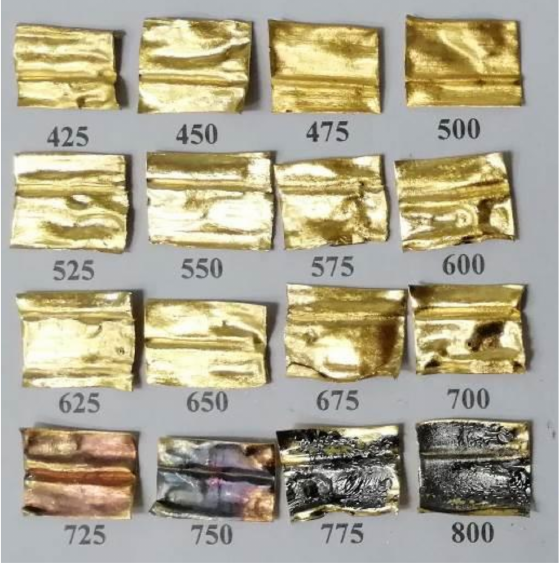
Figure 3. Inner wall photo of tube heated to different